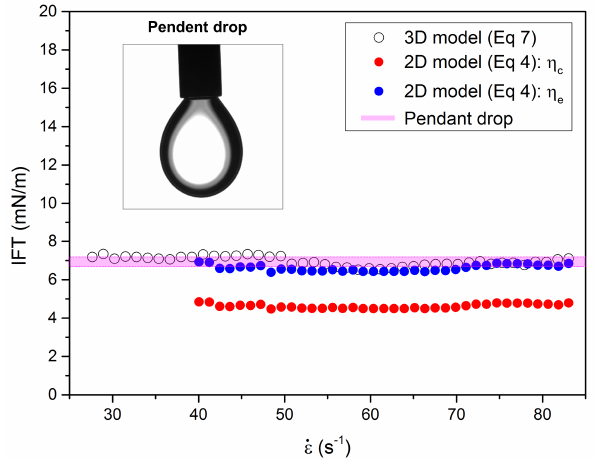
Figure 6. Interfacial tension results obtained by three different methods. A conventional pendant drop method is employed (colored in pink region). The interfacial tensions are compared with quasi-static 2D Darcy approximation (Equation (4)) and 3D small deformation models (Equation (7)). For the 2D Darcy approximation model, we calculated the IFT based on Equation